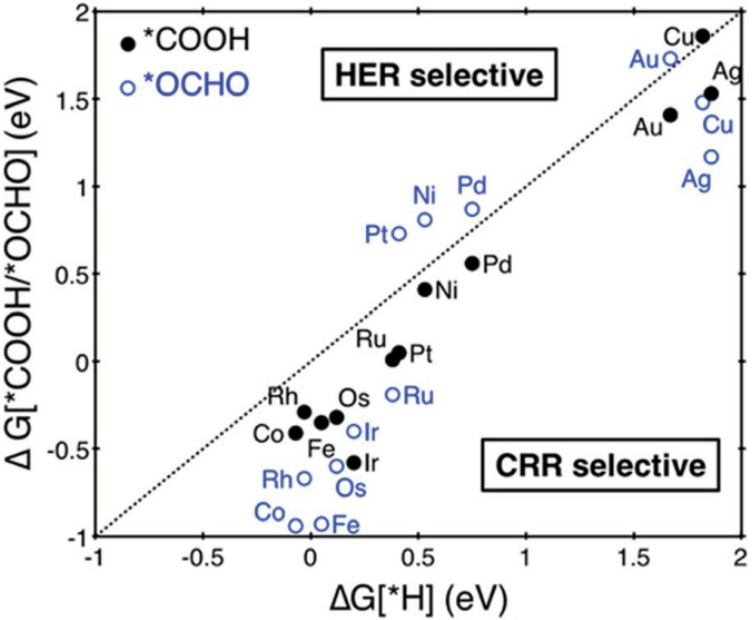
Figure 9. Free energy change in the first protonation step in ECR and HER on different SACs. Catalysts below the dotted parity line are ECR selective. Reprinted from [152], Copyright (2017), with permission from Royal Society of Chemistry.